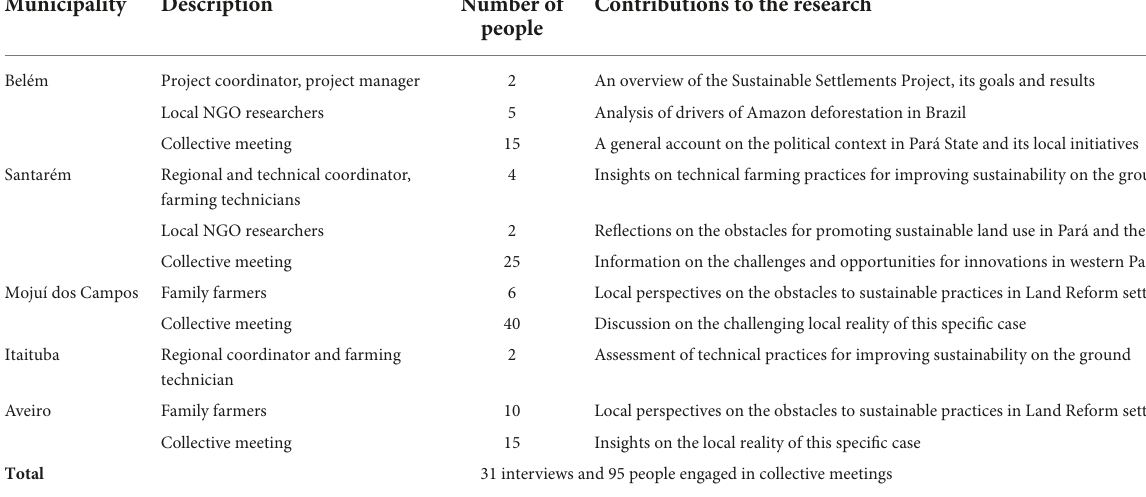
TABLE 2 Engagement with stakeholders in Pará State,